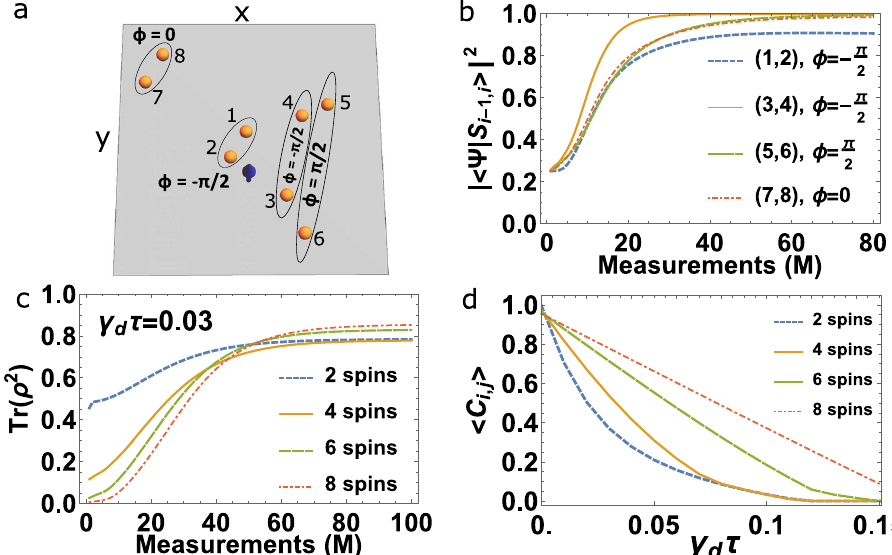
Figure 2. ( a ) Nuclear spins are randomly distributed in the x − y plane and pair up into the entangled state 1 i = − − − φ  S [ 1, 1 e 1, 1 ] . We also show the relative phase φ of each pair in this configuration. ( b ) We i j , 2 plot the entanglement fidelity for various pairs as function of measurements M . ( c ) The purity is shown as a function of the number of measurements for different spin numbers in the presence of dephasing. ( d ) The average pairwise concurrence of the steady state is plotted as a function of the dephasing rate γ d multiplied by τ